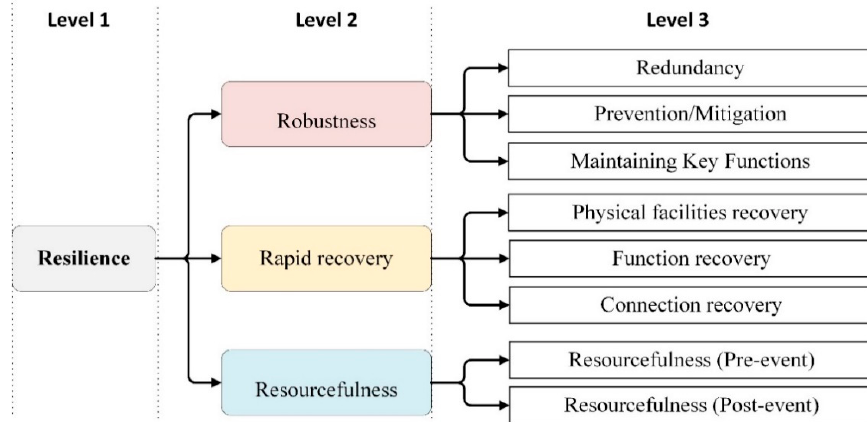
Figure 1. Indicators in the first three levels of the resilience indicator system. (1) Robustness According to the implication of robustness, three components, namely redundancy, prevention/mitigation, and maintaining key functions, are used to demonstrate the term. The 6-level resilience indicators of robustness are shown in Appendix A Table A1. a. Redundancy